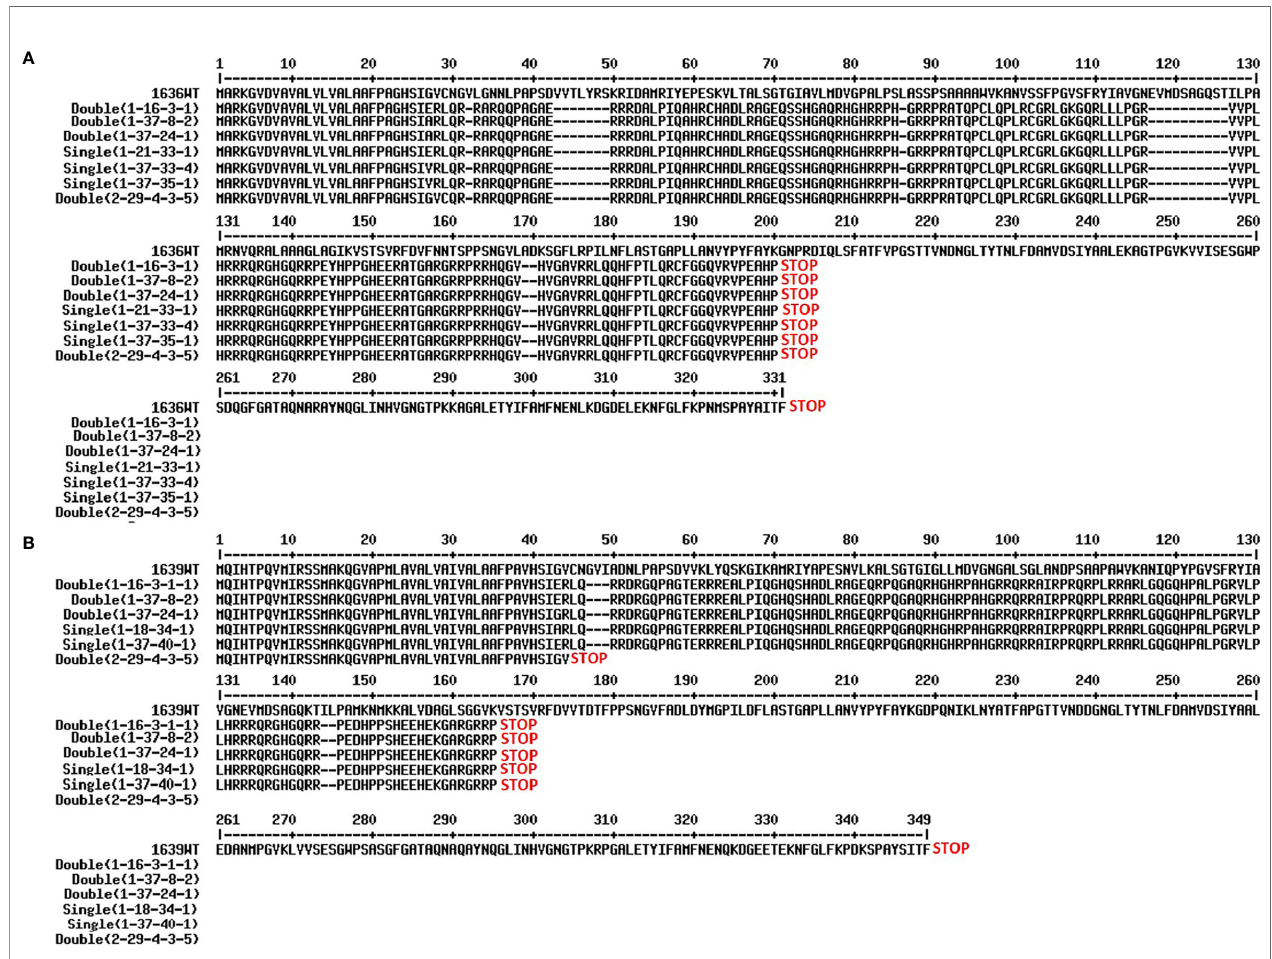
FIGURE 6 | Predicted proteins from the 1636 (A) and 1639 (B) mutant lines. Translation of genes from cultivar Morex wild type (WT) is compared with translations of the nine mutant lines.